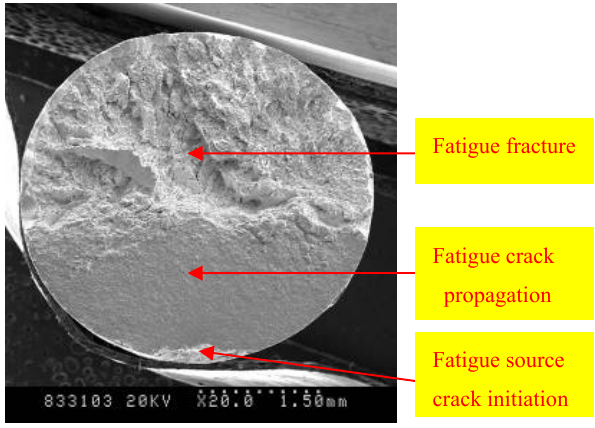
Figure 5. SEM images of fatigue